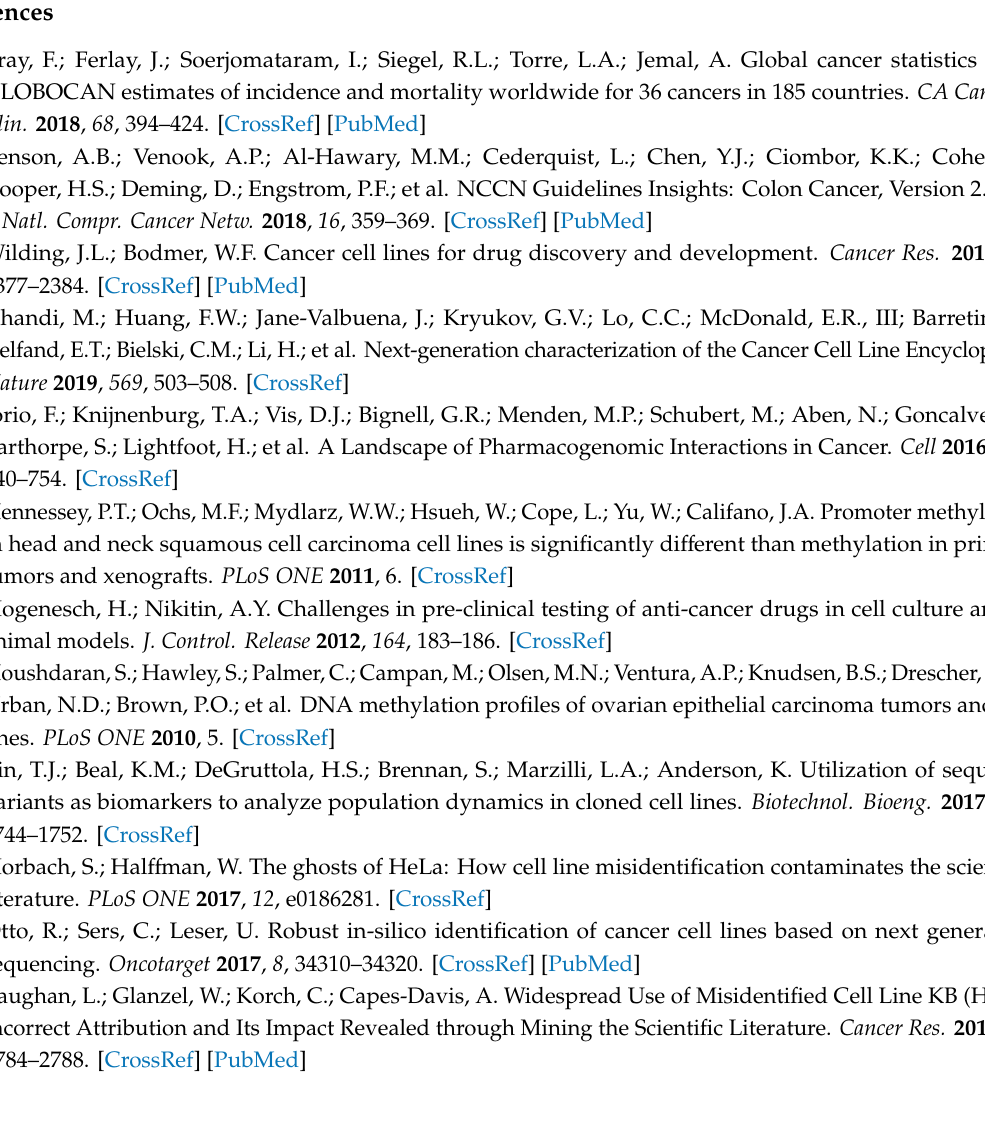
PDX tissue, Figure S6. Patient-derived xenograft tumor latency, Figure S7. Immunohistochemical characterization of proliferation in CRC patient-derived xenografts, Table S1. Characteristics of the patients from with PDXs were derived, Table S2. Summary of the PDX success rates in the context of patient